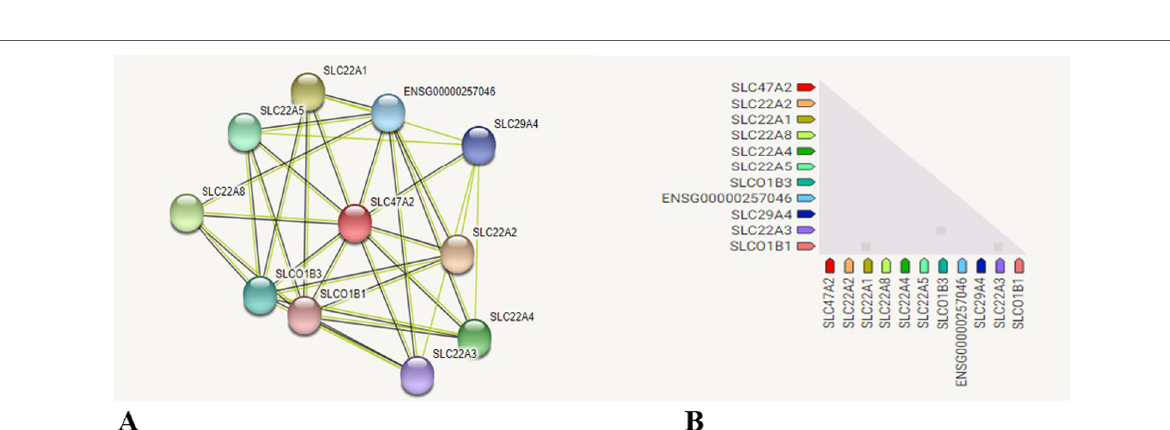
Fig. 4 a MATE2 protein–protein interactions with its partners b Coexpression pattern of the genes which correlates with the gene encodes